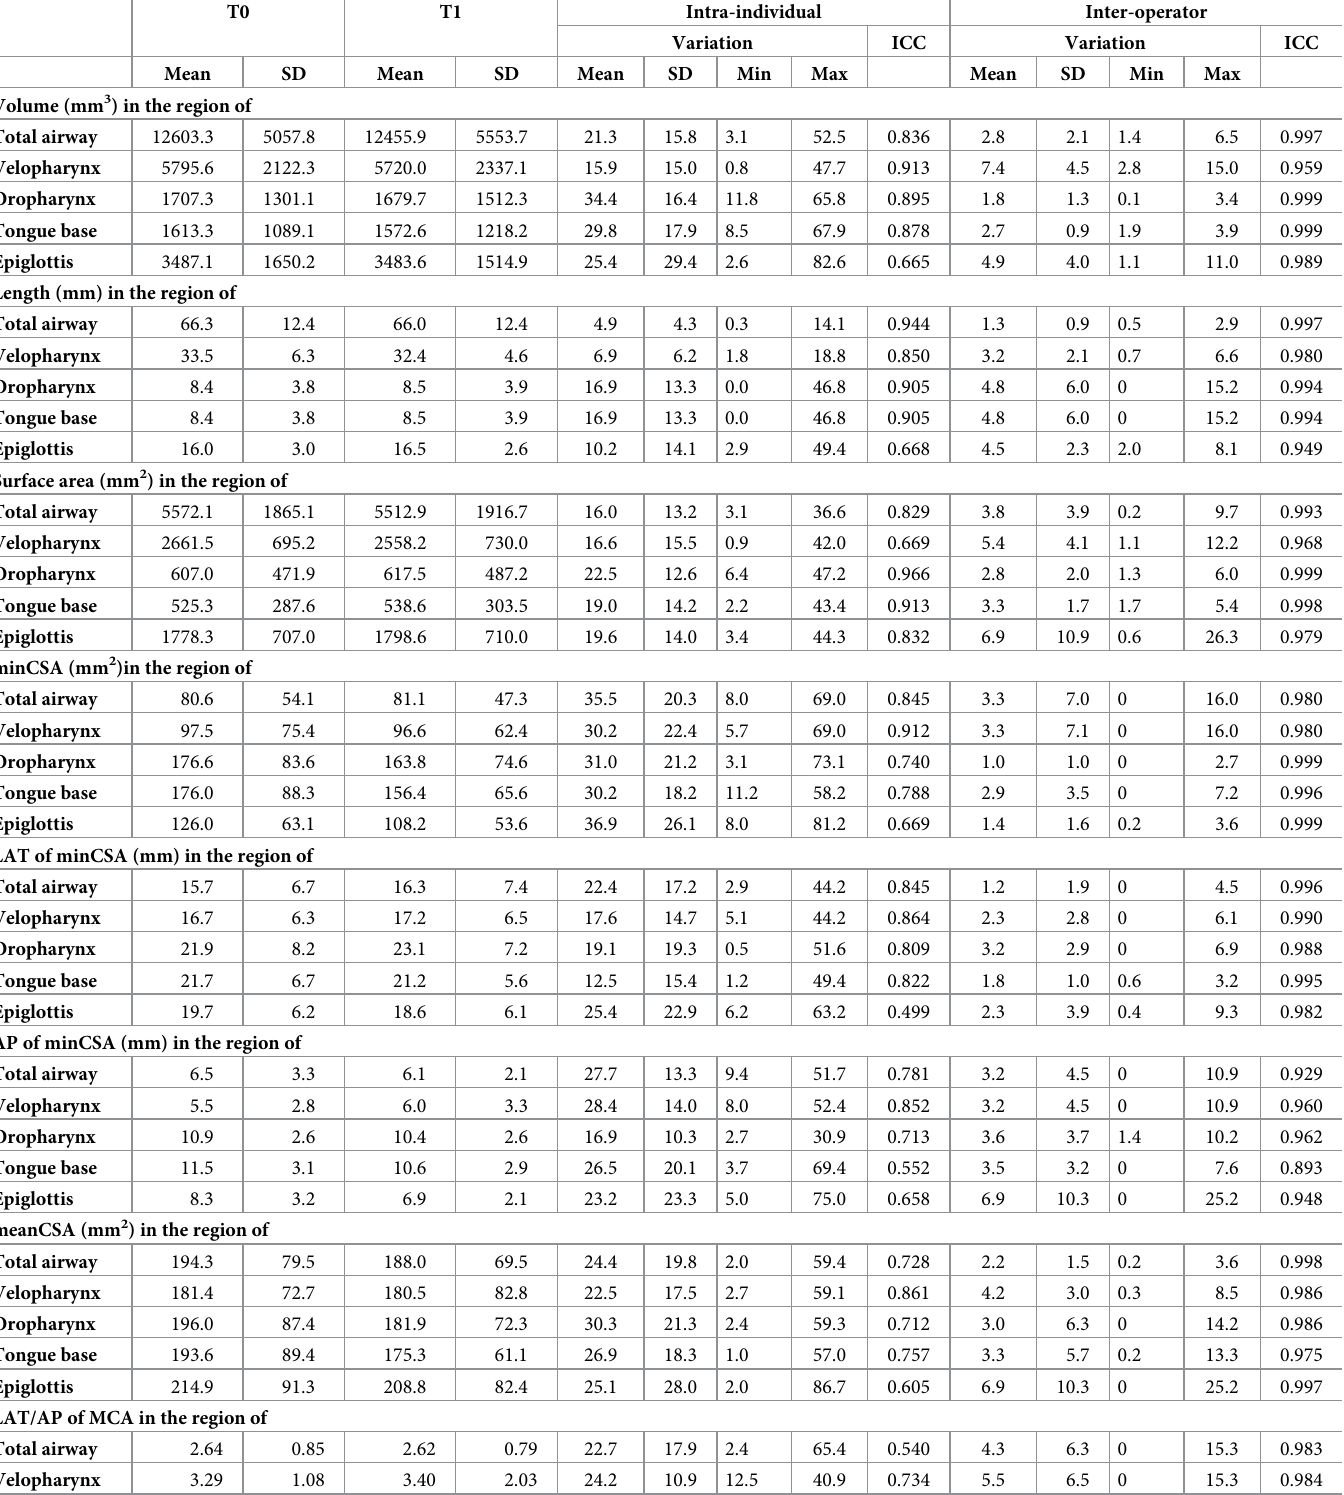
Table 2. Descriptive statistics of variables (N = 10), intra-individual variation and repeatability (N = 10), and inter-operator variation and reliability (n = 5).